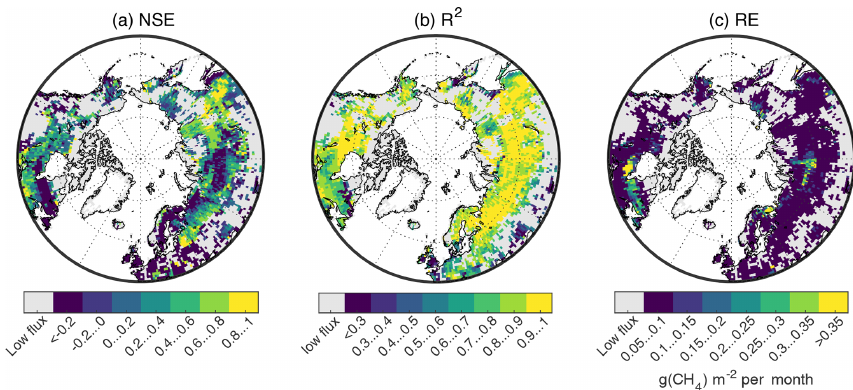
Figure 8. NSE, R 2 and RE calculated between RF-DYPTOP and LPX-Bern. Grid cells with low CH 4 wetland emissions (below 0.1g(CH 4 )m − 2 yr − 1 ) are shown in grey. RE values refer to total unit area in a grid